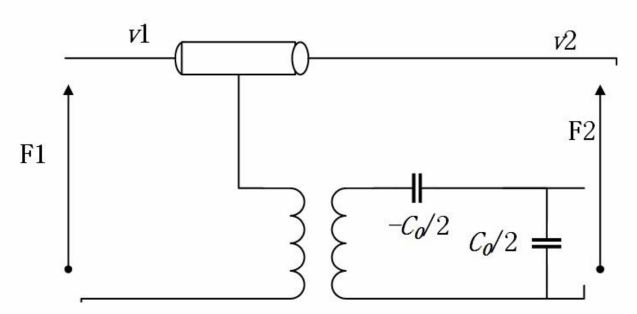
Figure 3. The Schematic diagram of nonlinear Mason equivalent circuit